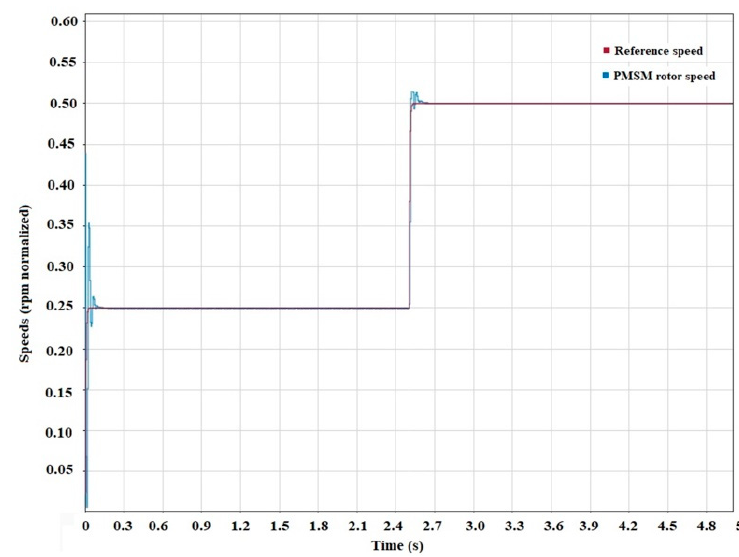
Figure 26. Generate and build code of the control software algorithm subsystem. Figure 27. SIL/PIL manager settings for the control algorithm testing.